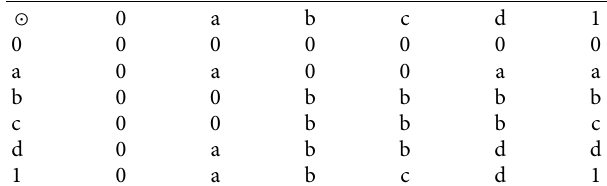
Figure 2: Hasse diagram of A . Table 1: Cayley table of